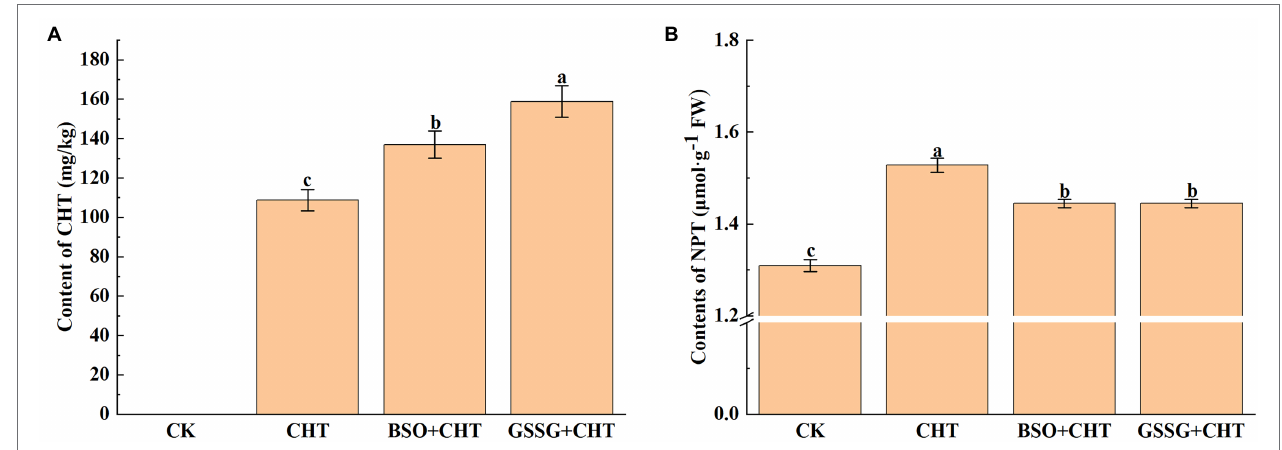
FIGURE 1 | Pesticide residue (A) and NPT content (B) under exogenous treatment in tomato. NPT, non-protein thiols; CHT, chlorothalonil; BSO, L-buthionine- sulfoximine; and GSSG, glutathione (oxidized). Error bars represented the SD ( n = 3). According to Duncan’s multiple test, bars with different letters were significantly different ( p <